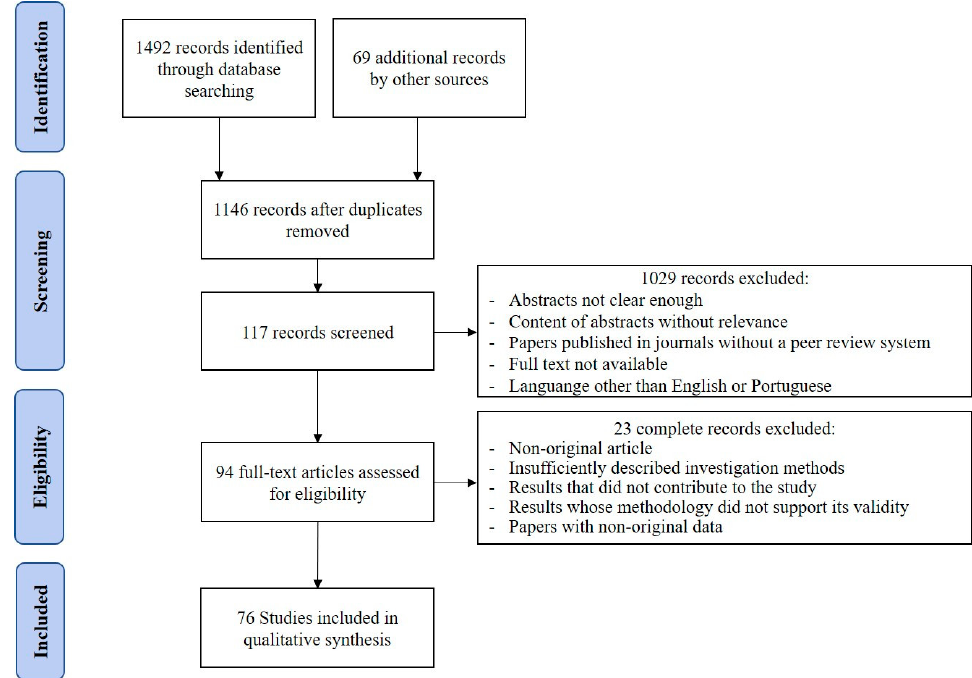
Figure 4. Bibliographic search flowchart using the Preferred Reporting Items for Systematic Reviews and Meta-Analyses (PRISMA) method.